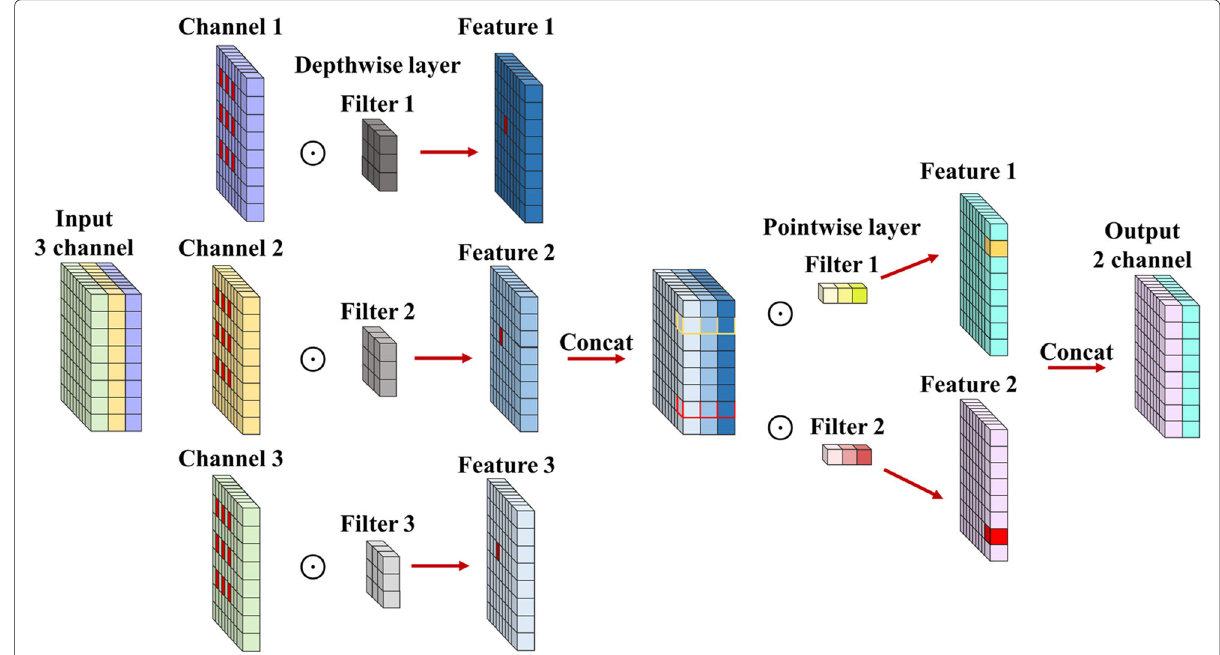
Fig. 3 Block diagram of the depthwise separable convolution with dilated filter in